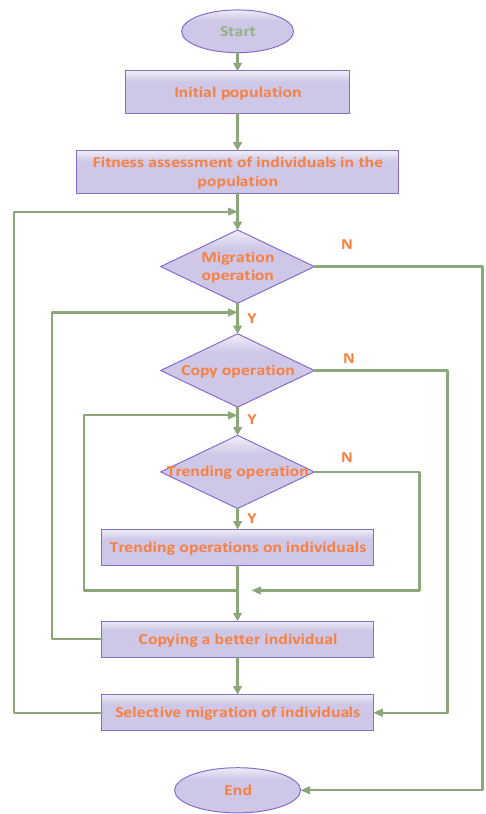
Figure 2. Flow chart of the bacterial foraging process.